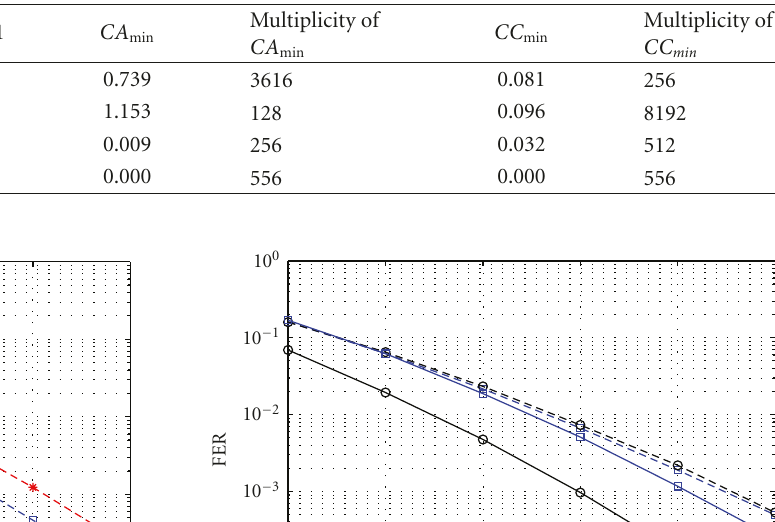
Table 3: Comparison of new (NC4, NC5) and reference (V4, V5) 8PSK codes.